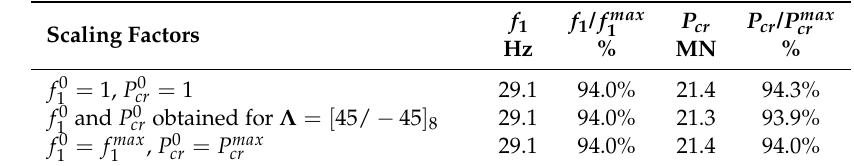
Table 4. Nadir points in SM approach.